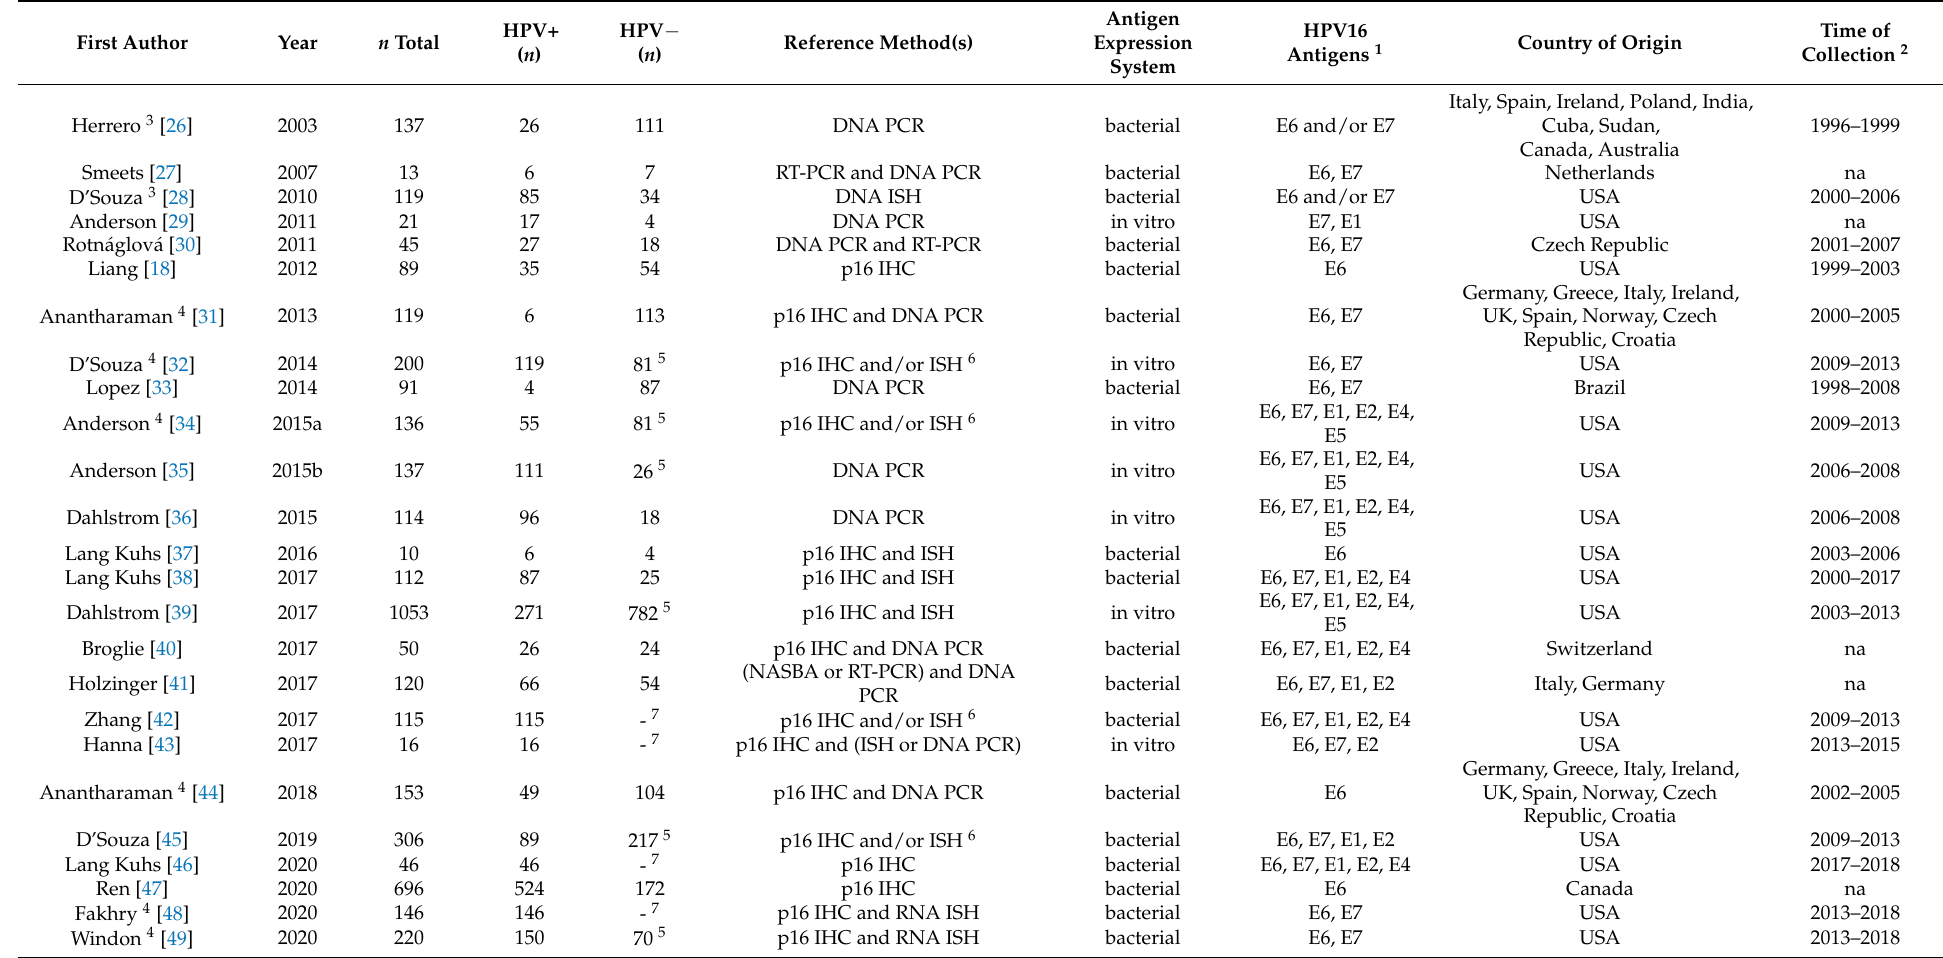
Table 1. Summary table of main characteristics for all studies included in the systematic review ( n = 25) and meta-analysis ( n = 23) sorted by year of